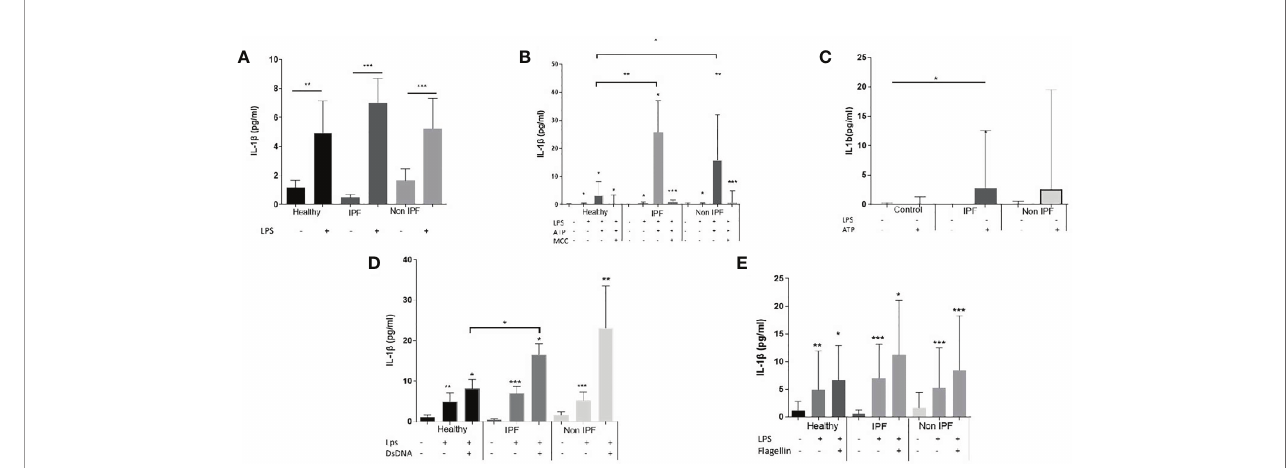
FIGURE 2 | Assay of in fl ammasomes activation in Airway Macrophages (AMs). (A) AMs treated for 5 hours with LPS (B) Activation of NLRP3 upon priming with LPS for 2 hours and ATP for 30minutes. Cells were also treated in presence of the Selective NLRP3 inhibitor MCC950 to show speci fi city of the NLRP3 activation, (C) AMs cultured for 2 hours in serum and treated for 30 minutes with ATP without priming with LPS (D) AIM2 in fl ammasome activation: 1 hour of LPS priming followed by 4 hours dsDNA transfection, (E) NLRC4 in fl ammasome activation: 1 hour of LPS priming followed by 4 hours fl agellin transfection. For with-in group analysis one-sided paired Wilcoxin test was used. For between group analysis Mann-Whitney test was used. Data presented as median with interquartile range, *p<0.05, **p<0.005,